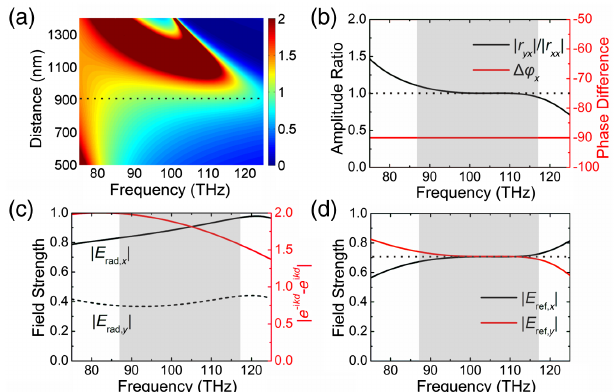
FIG. 3. (a) Relationship of the interlayer thickness d , the frequency and the amplitude ratio of the reflected light. The color represents the amplitude ratio of the reflected light. (b) Calculated amplitude ratio and phase difference of the reflected light under the x -polarized incident light, which is similar to that shown in Figs. 1(d) and 1(e). (c) Amplitude of the x and y components of the irradiation of the structure and the amplitude of j − e ikd þ e − ikd j , as a function of frequency. (d) Calculated amplitude of the x and y components of the reflected